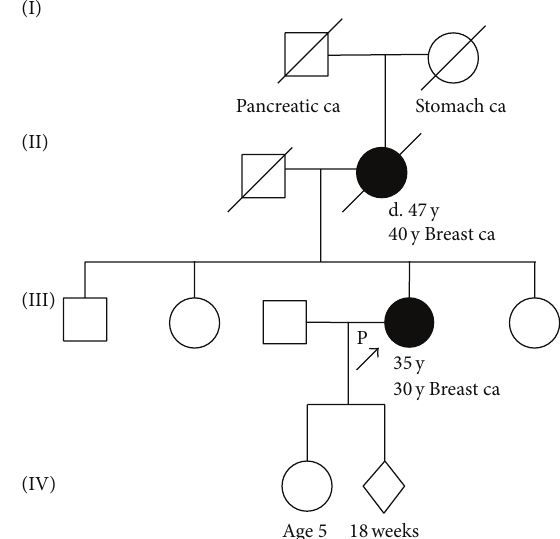
Figure 2: Pedigree of the patient’s family. The cancer type or site followed by the age of diagnosis is indicated for pancreatic carcinoma(Pancreaticca)andbreastcancer(Breastca)andstomach cancer (Stomach ca). The age in years or weeks (wks) at the time of ascertainment or age at death (d.), if known, is